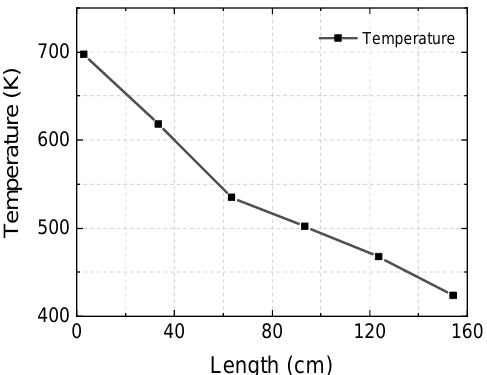
Figure 8. The temperature data along the optical length with typical experiment conditions at Φ = 0.89.